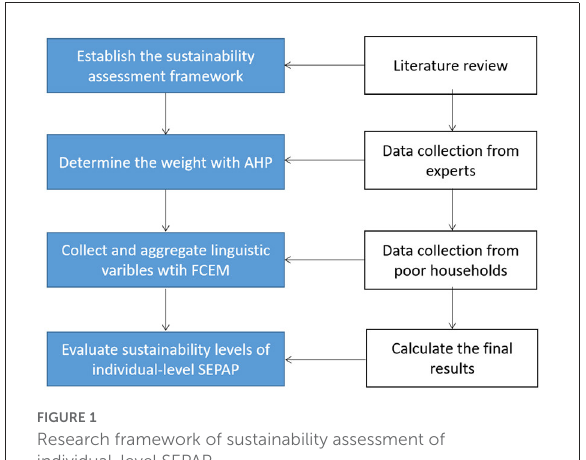
FIGURE1 Research framework of sustainability assessment of individual-level